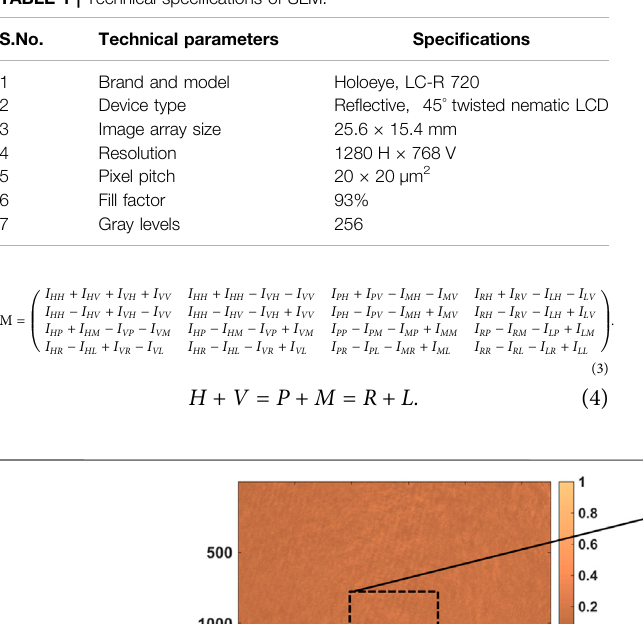
TABLE 1 | Technical speci fi cations of SLM.